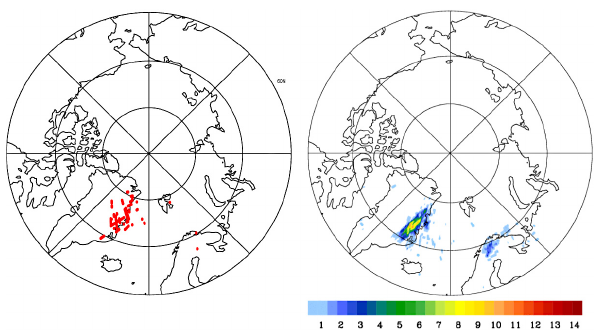
Fig. 14. Locations of wave ice PSCs as observed by CALIPSO ( R > 50) during 31 December 2009–14 January 2010 (left panel) and mountain wave occurrence (number of six-hourly events) as derived from the ECMWF horizontal divergence conditions DIV > 2 × 10 − 4 s − 1 (right panel) at 30 hPa for the same period. Opera- tional ECMWF T799 analyses interpolated at a regular 0.5 ◦ × 0.5 ◦ latitude/longitude